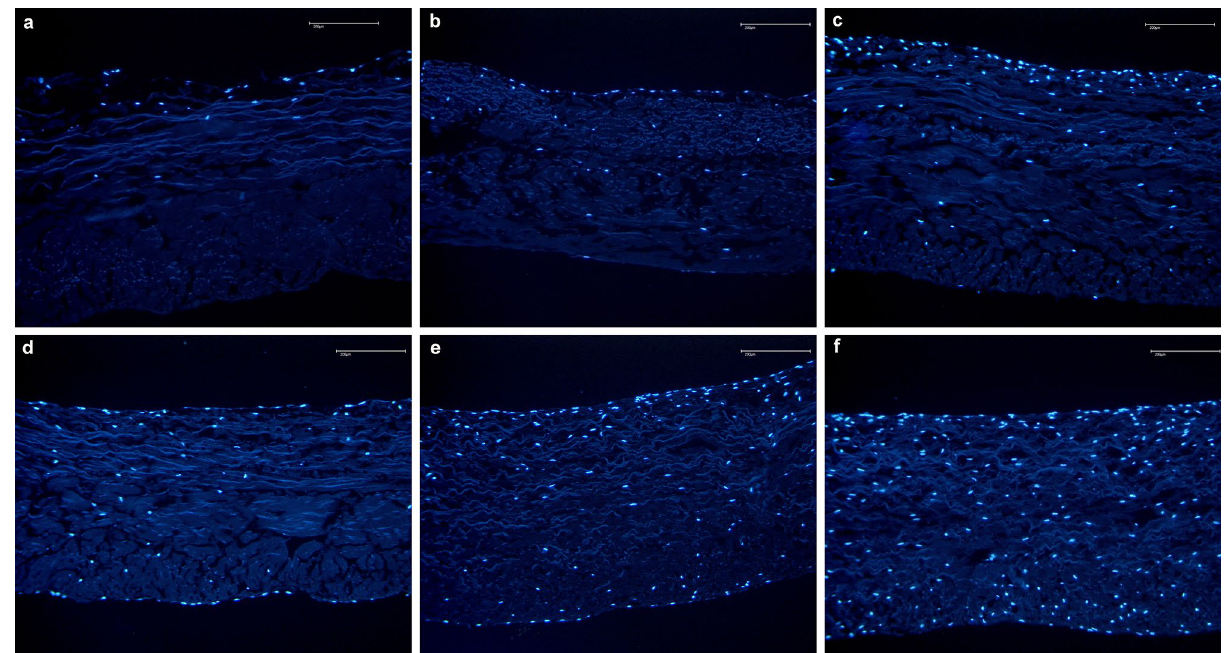
Figure 5. Proliferation and migration of B-MSCs in the membrane without fibrin using the DAPI stained cell nuclei of B-MSCs (blue) assay. Time dependent proliferation and migration of B-MSCs into the non-fibrin treated membrane over 1, 2, 3, 4, 6, and 8 weeks (pictures a – f , respectively).